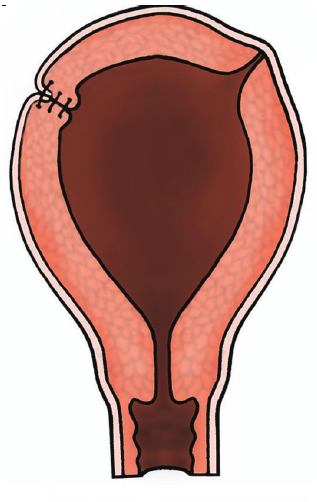
Figure 2: An incision along the right cornu immediately reached the endometrial cavity at a depth of 2.5 mm revealing extremely thin uterine wall.